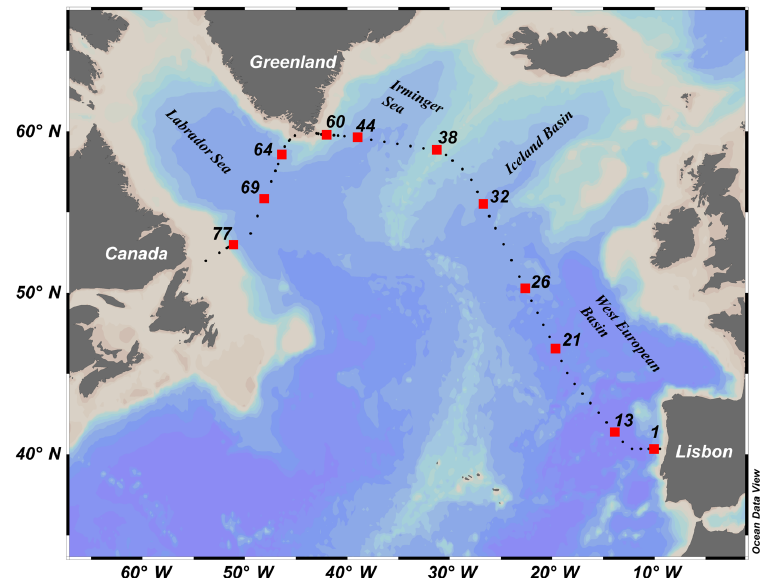
Figure 1. Map of the GEOVIDE cruise track (black dots) and the 11 stations sampled for 210 Po and 210 Pb activity (red squares). Each sampling location is labeled with a station number. The sampling stations are divided into four regions (from east to west): West European Basin (stations 1, 13, 21, 26), Iceland Basin (stations 32, 38), Irminger Sea (stations 44, 60), and Labrador Sea (stations 64, 69,